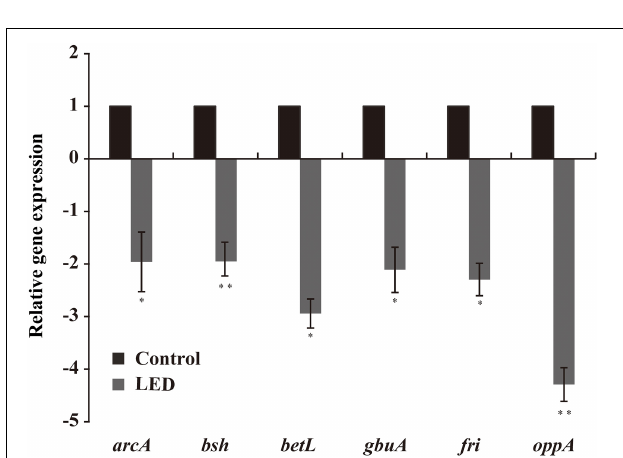
FIGURE 6 | Effects of LED treatment on the transcription of genes associated with the resistance of L. monocytogenes to environmental stresses. ∗ P < 0.05 and ∗∗ P < 0.01 versus the